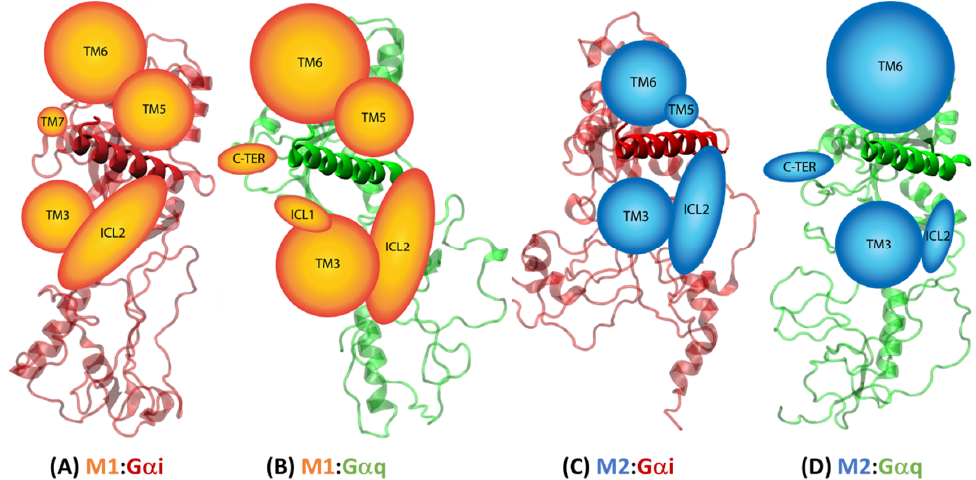
Figure 8. Strong noncovalent interactions between receptors and Gα proteins mapped to individual domains in the receptor for the complexes: ( A ) M1:Gαi, ( B ) M1:Gαq, ( C ) M2:Gαi, and ( D ) M2:Gαq, The size of the receptor domain is proportional to the number of its contacts with the Gα protein (Table S1) and stability of the interaction during the simulation. The structure of the Gα protein is shown but the receptor is only represented by circles for strongly interacting transmembrane (TM) domains and ovals for non-TM domains like intracellular loops (ICLs) and the C-terminus (C-TER). The residues involved in individual interactions between the receptors and Gα proteins are provided in Table S1 along with their relative stability during the 2 μs simulation time. Receptor–G protein contacts specific to the M1 receptor that were found in both M1 complexes but not in the M2 complexes are (ASN422 CTER -G.H5.22), (THR218 5.68 -G.H5.16), (THR218 5.68 -G.H5.13), (ALA135 IC2 - G.Hns1.3), (ILE211 5.61 -G.H5.25), and (ARG134 IC2 -G.H5.15), where the first residue belongs to the M1